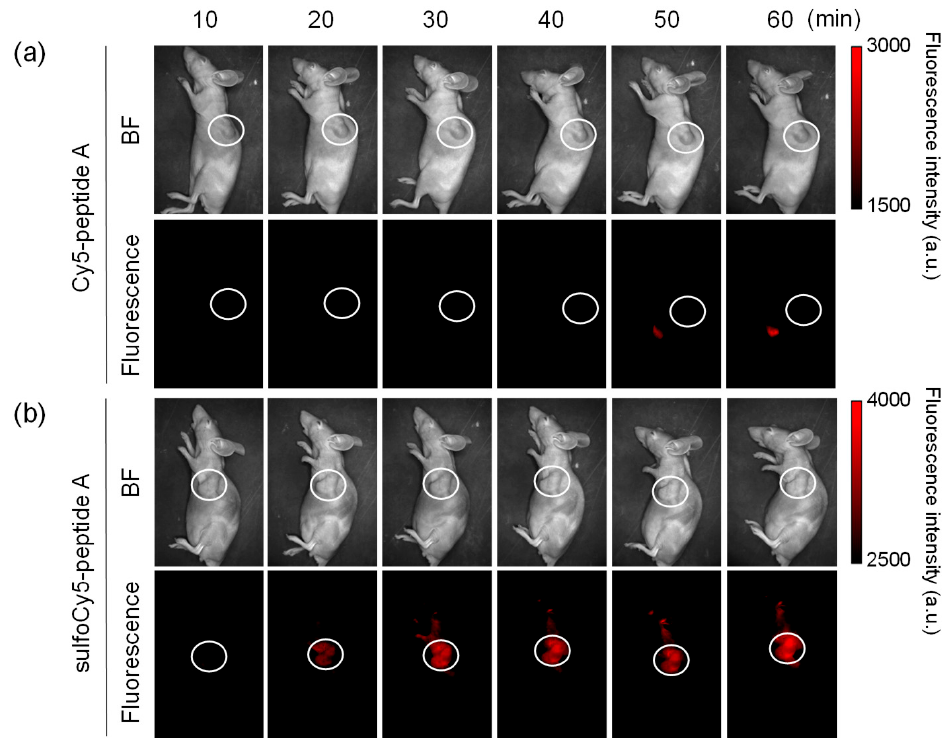
Figure 5. In vivo fluorescence imaging of tumor-bearing mice injected with dye-peptide A. The tumor-bearing mice were intravenously given 0.1 mL of ( a ) 100 µ M Cy5-peptide A and ( b ) 100 µ M sulfoCy5-peptide A. Ten minutes after the injection, the images were taken from a side view. The tumor is indicated by white circles. The in vivo experiment was performed three times.